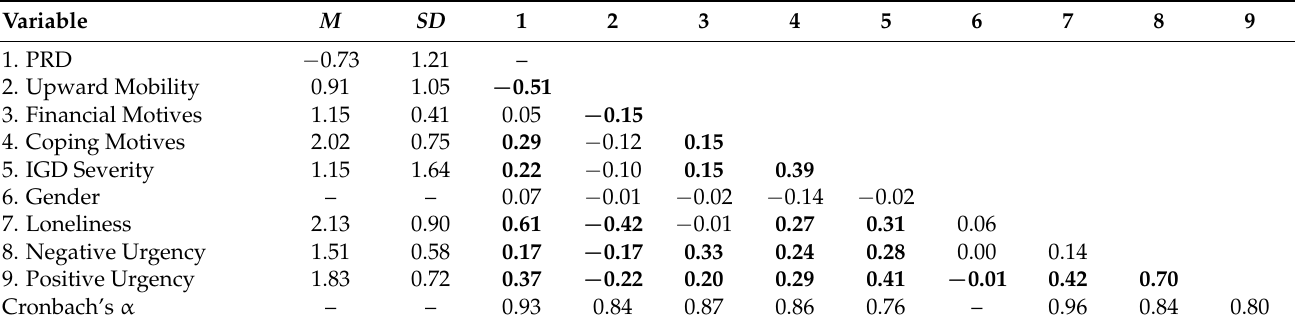
Table 3. Study 2 (cid:48) s descriptive statistics, internal consistencies, and correlations for main